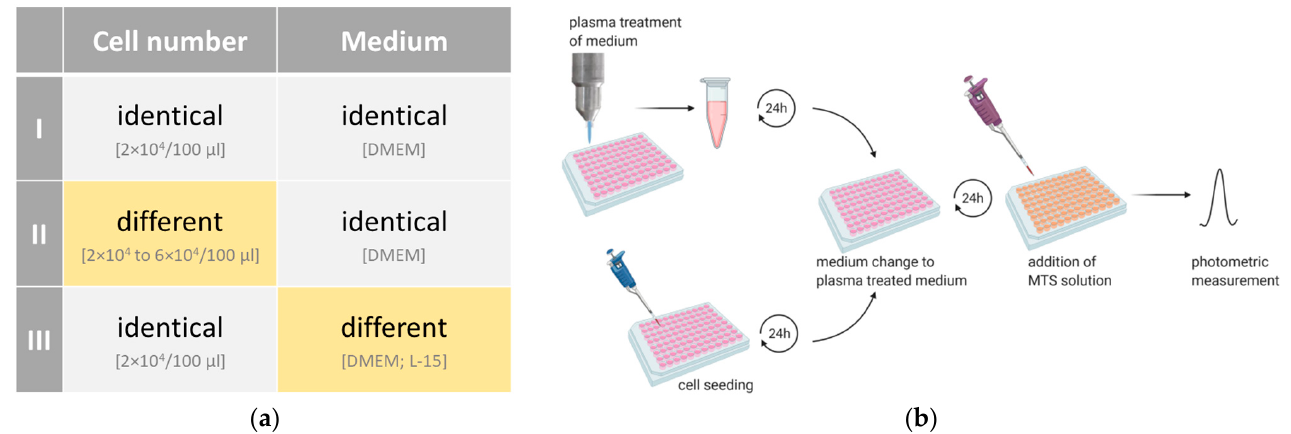
Figure 1. Overview of the experimental setup. ( a ) gives a summary of the different cell culture conditions, while ( b ) shows a schematic workflow of the experiment (created with BioRender.com accessed on 26 January 2021).